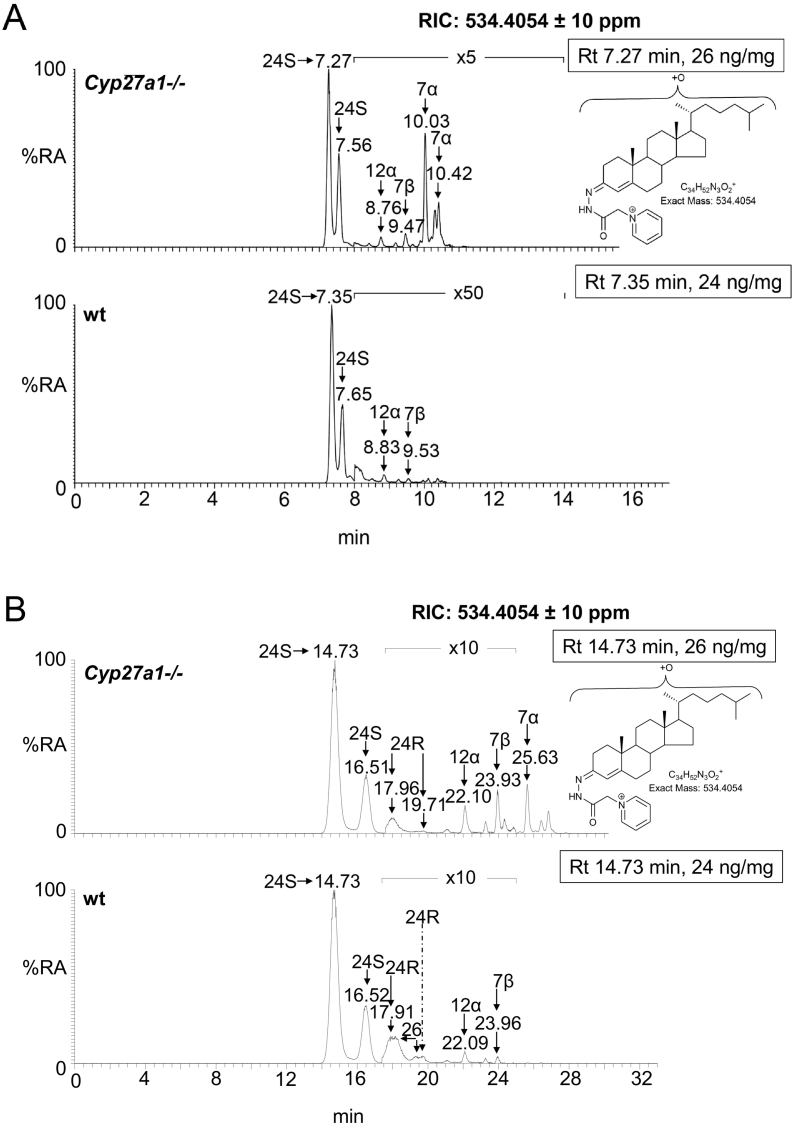
Oxysterols in Cyp27a1−/− and Cyp27a1+/+ (wt) mouse brain. Each chromatogram is normalised to the most intense peak at 100% RA. Magnification factors are as indicated. The concentration of the indicated analyte (by Rt) is given in the right-hand corner of each chromatogram. Chromatograms from the oxysterol fractions treated with cholesterol oxidase (combination of sterols with a native 3-oxo group and those oxidised by cholesterol oxidase to contain a 3-oxo group) are shown. The insets show structures of generic GP derivatives. Many oxysterols elute as twin peaks corresponding to syn and anti conformers. (A) Monohydroxycholesterols and monohydroxycholest-4-en-3-ones. (B) As in (A) but over an extended gradient. (C) Dihydroxycholesterols and dihydroxycholest-4-en-3-ones. (D) Trihydroxycholesterols and trihydroxycholest-4-en-3-ones. (E) 3β,24-Dihydroxycholest-5-ene-25-methoxide, the methanolysis product of 24S,25-epoxycholesterol. (F) Monohydroxycholestenones, monohydroxydehydrocholesterols and monohydroxycholesta-4,6(or24)-dien-3-ones. In (A-D) peaks are labelled according to the respective location of hydroxy groups on the core cholesterol or cholest-4-en-3-one structure. In (E) and (F) the abbreviations are 24H,25 M, 3β,24-dihydroxycholest-5-ene-25-methoxide; 24,25-EC, 24S,25-epoxycholesterol; 24O-C, 3β-hydroxycholest-5-en-24-one; 7α-HD, 7α-hydroxydesmosterol; 12α-HCdO, 12α-hydroxycholestadien-3-one.